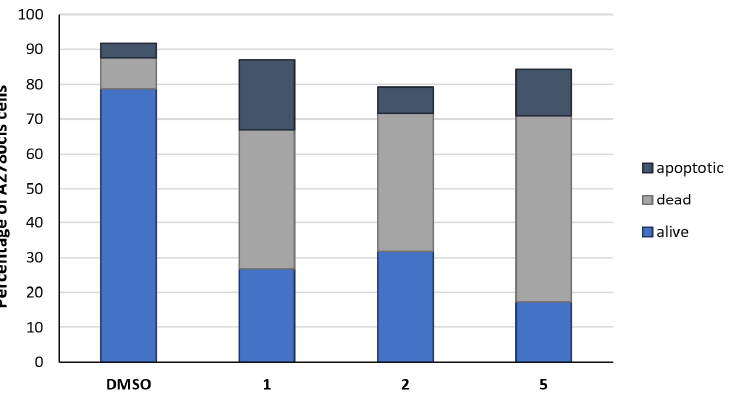
Figure 4. Differentiation of the A2780cis cell population (%) into apoptotic (dark blue), dead (grey), and alive cells (blue), after incubation for 24 h without compound (neg. control, DMSO) and with 1 , 2 , or 5 (1 μ M). Data are expressed as mean of two experiments.